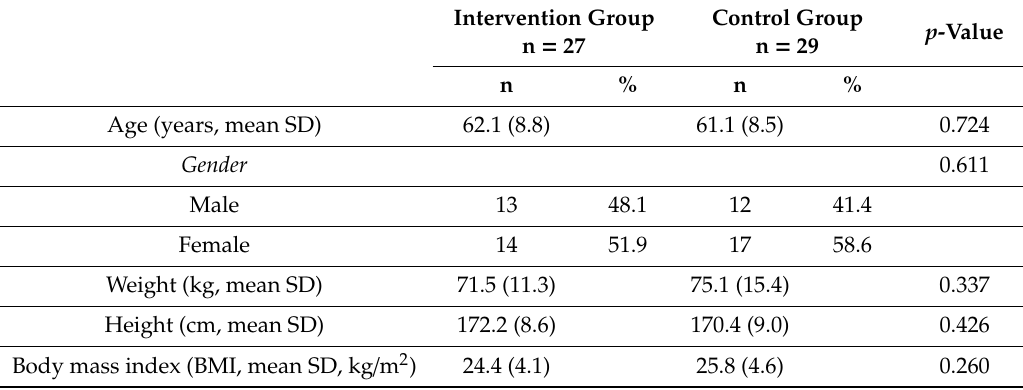
Table 1. Demographics. Baseline characteristics of randomly assigned participants.